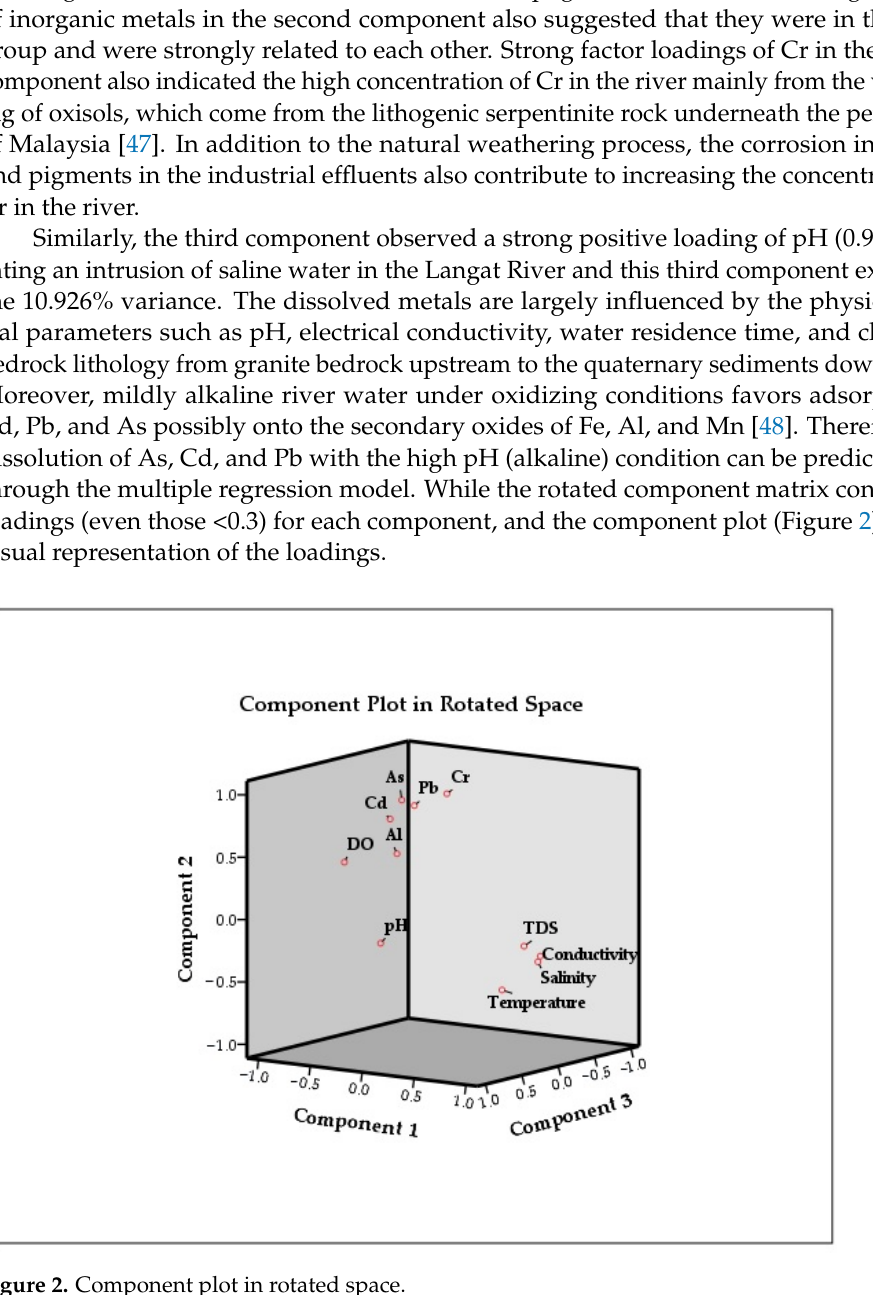
Figure 2. Component plot in rotated